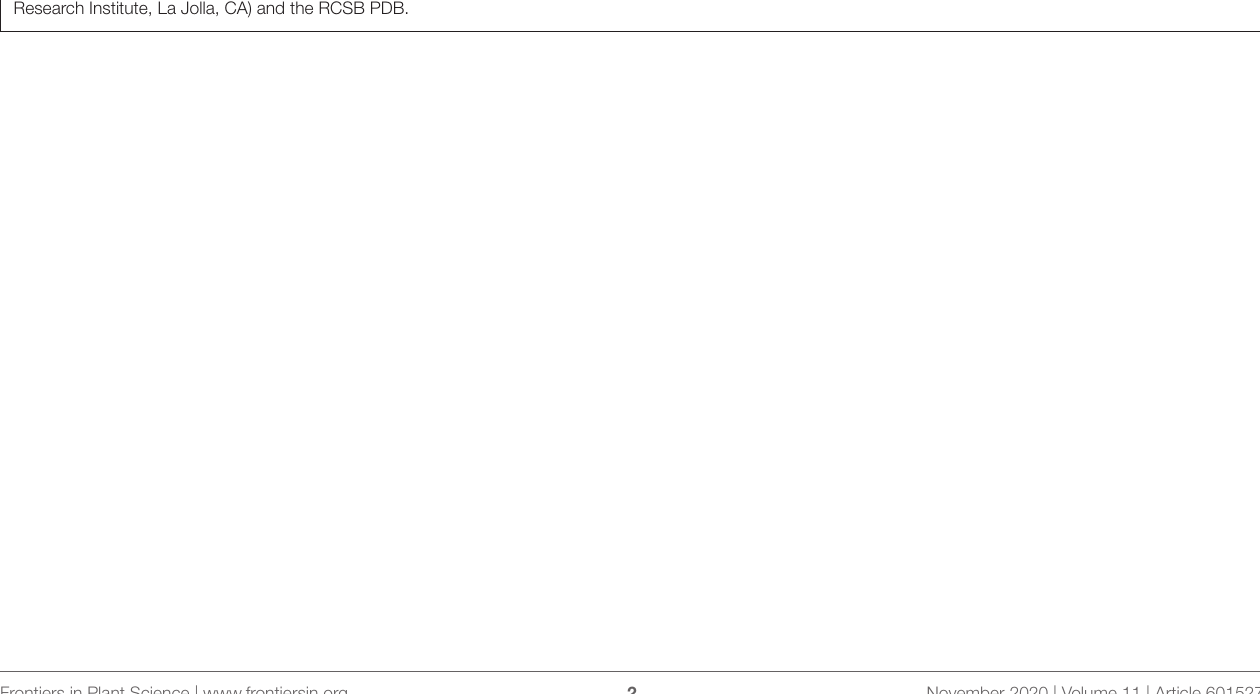
FIGURE 2 | Hypothetical model of the four defense mechanisms of rice against excess Fe. Defense 1: Fe excess tolerance by Fe exclusion in the roots. Defense 2: Fe-excess-tolerance by Fe retention in root and avoidance of Fe translocation to shoot. Defense 3: Fe excess tolerance by Fe compartmentalization in the shoot. Defense 4: Fe excess tolerance by ROS detoxification in the plant. DC, Discrimination center; NA, nicotinamine. Red letters, highly induced genes; Blue letters, highly suppressed genes. This figure is modified from the Supplemental figure of ( Aung et al., 2018b). The ferritin image was provided by Dr. David S. Goodsell (Scripps Research Institute, La Jolla, CA) and the RCSB